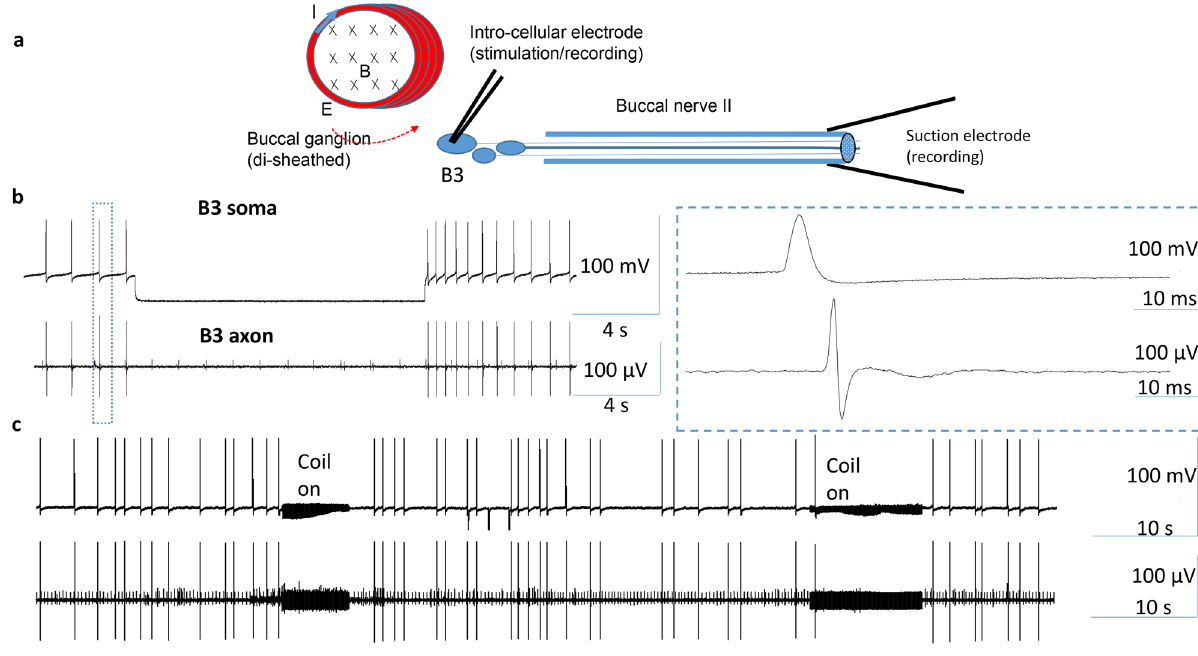
Figure 6. High-frequency magnetic stimulation on the soma inhibited functional output of the B3 motor neuron. ( a ) Experimental setup for the magnetic stimulation of the B3 neuron and assessment of its functional output. ( b ) Spontaneous B3 activity recorded in the soma and the axon demonstrated a one-to-one relationship. The soma action potential led the axonal action potential by approximately 6 ms. Hyperpolarization of the soma eliminated action potentials in both the soma and the axon. ( c ) Magnetic stimulation blocked spontaneous action potentials in the soma, leading to a suppressed activity in the distal axon.